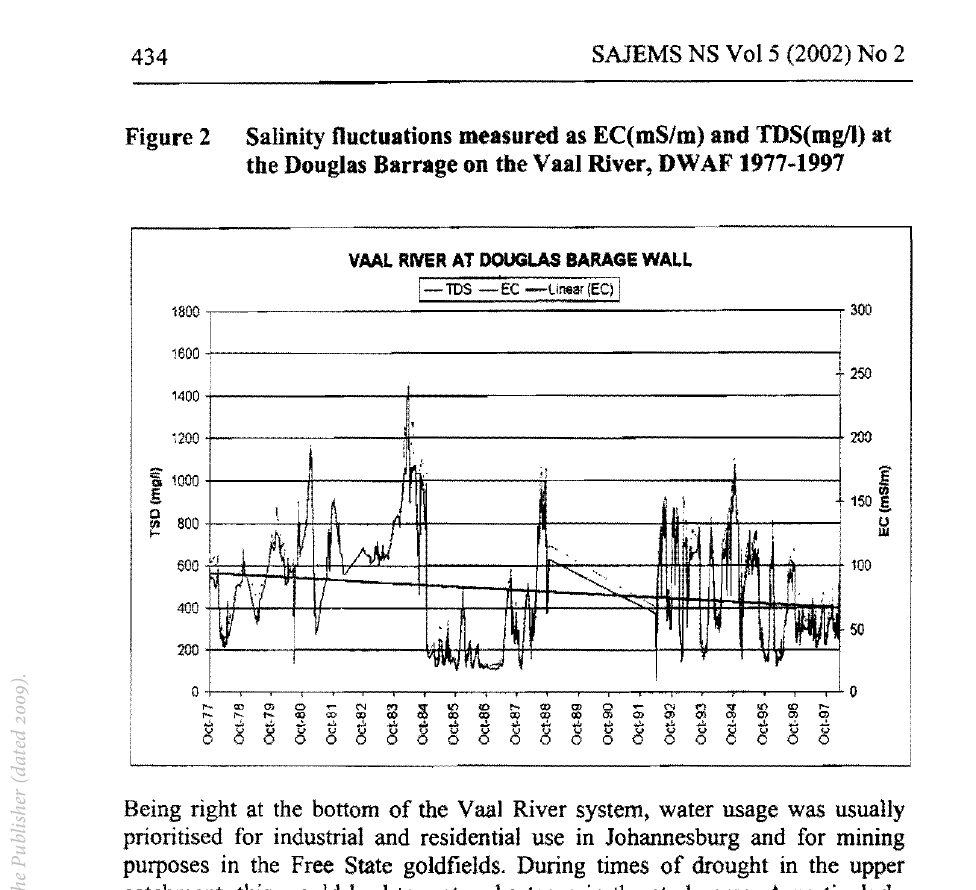
VAAL RIVER AT DOUGLAS BARAGE